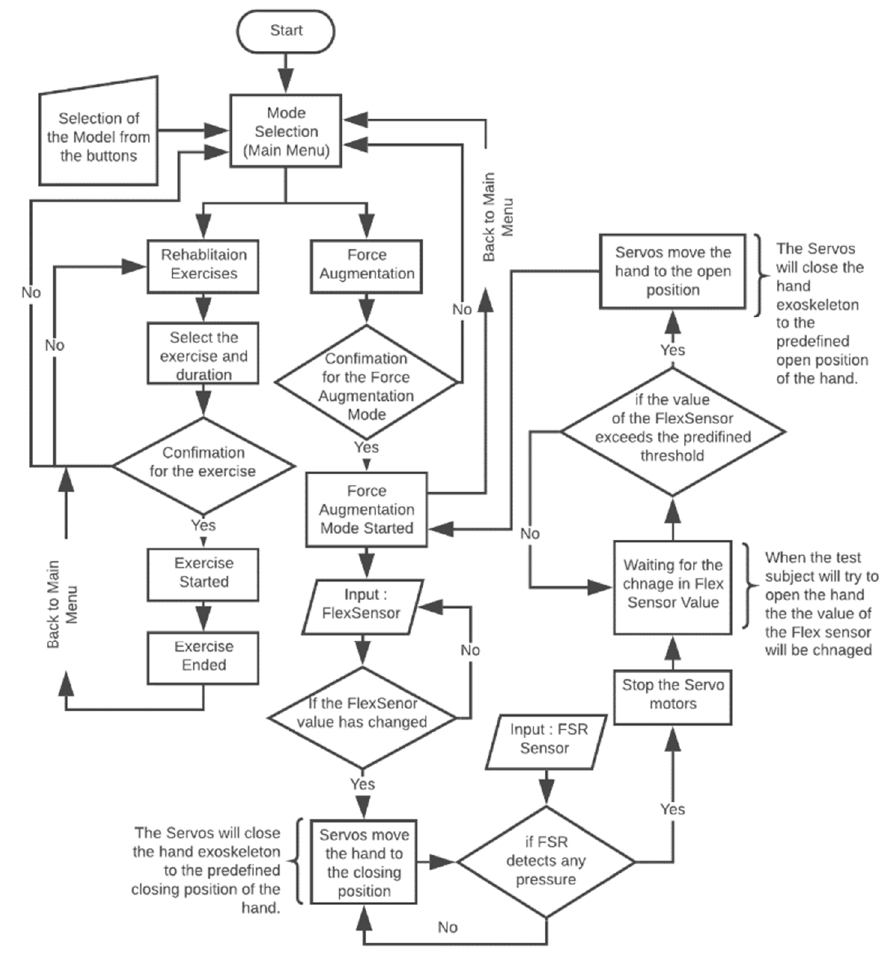
Figure 14. Flow chart for the control algorithm.